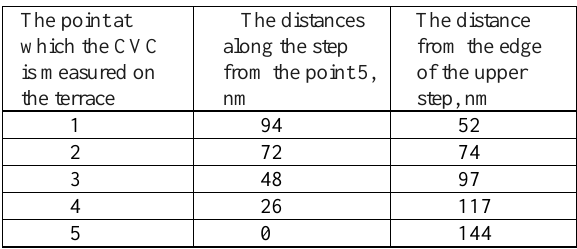
Table 1. Position of the points of CVC measured on a flat The point at which the CVC is measured on the terrace